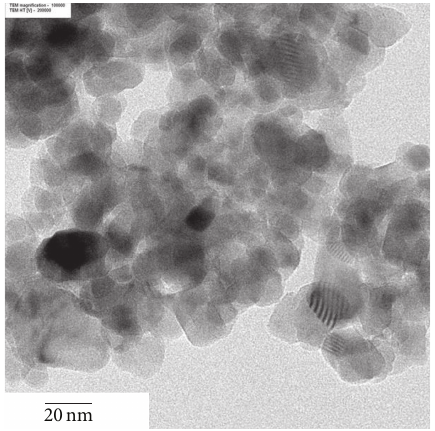
Figure 5: TEM micrograph of 1.0 mol% Au-loaded TiO 2